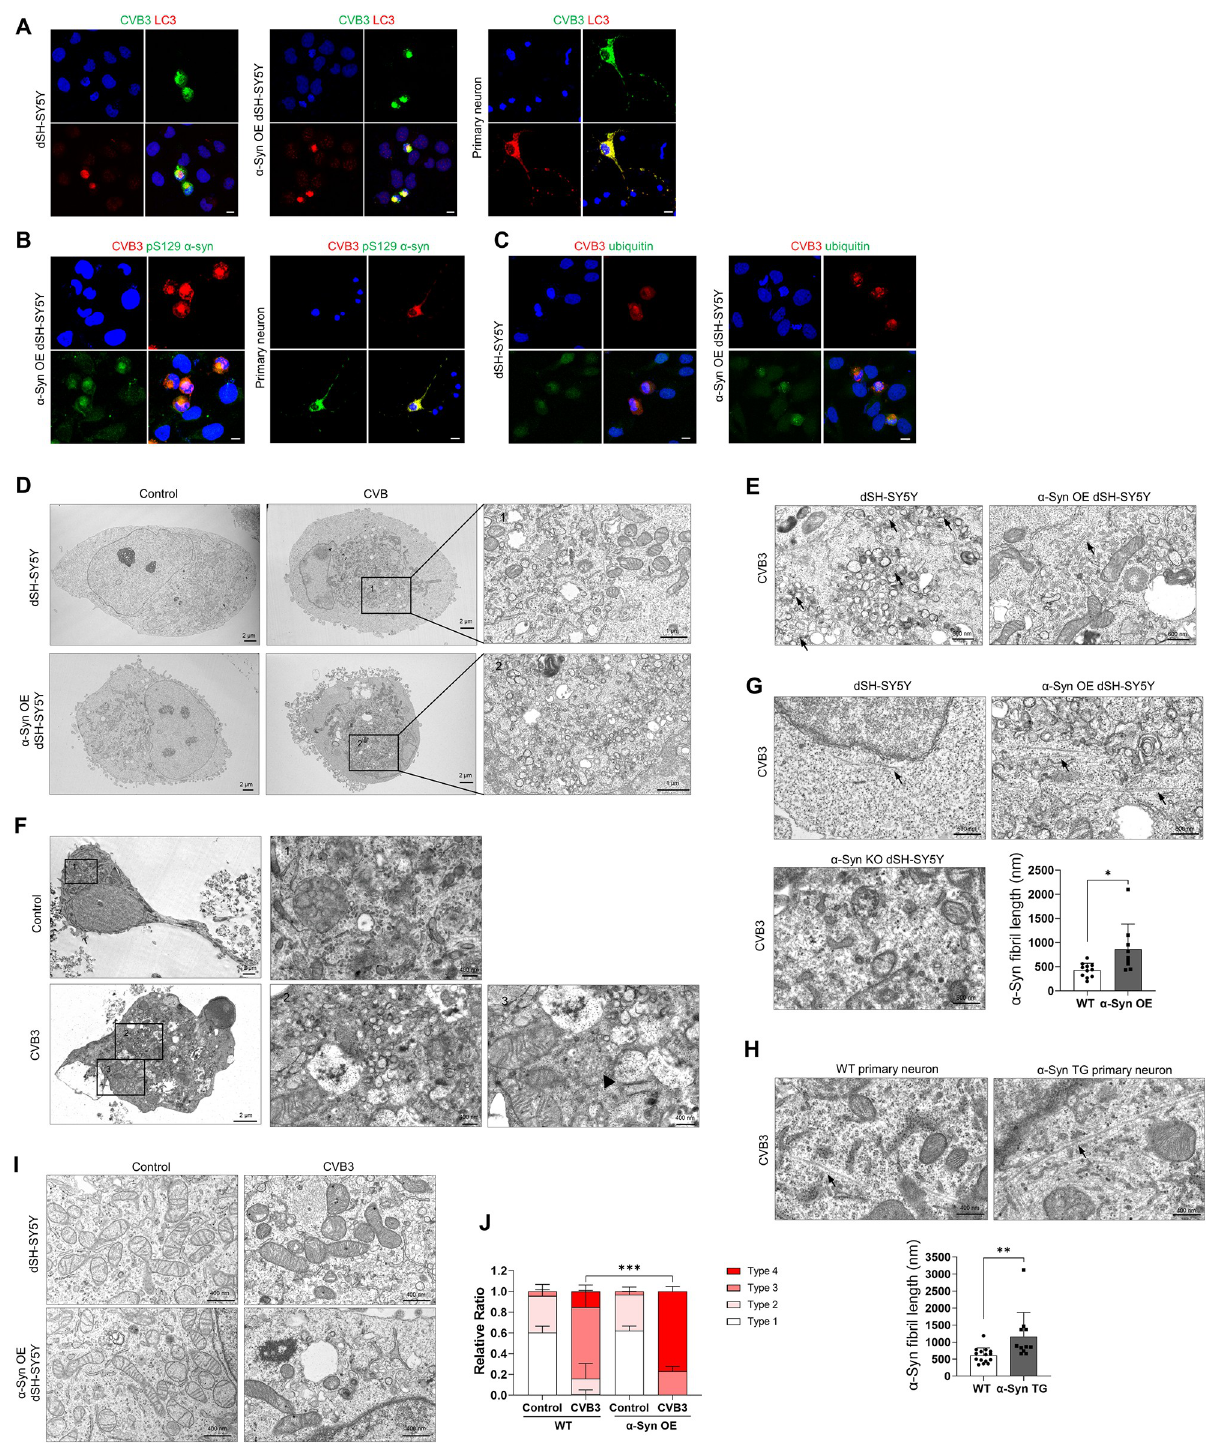
Fig 2. CVB3 infection induces Lewy body-like inclusion body formation in neurons. (A) ICC images of WT, α -syn OE dSH-SY5Y cells and mouse primary cortical neurons infected by CVB3 (MOI 0.25 or 5) for 24 h. Cells were immunostained for CVB3 VP1 (green) and MAP1LC3B (LC3) (red). (B) ICC images of α -syn OE dSH-SY5Y cells and mouse primary cortical neurons infected with CVB3 for 24 h. Cells were immunostained for CVB3 VP1 (red) and pSer129 α -syn (green). (C) ICC images of WT and α -syn OE dSH-SY5Y cells infected with CVB3 for 24 h. Colocalization of CVB3 VP1 (red) and ubiquitin (green) was observed. Scale bar indicates 10 μ m. Blue indicates Hoechst. (D) Transmission electron microscopy (TEM) images of control and CVB3 infected WT and α -syn OE dSH-SY5Y cells which were infected with CVB3 for 24 h. (E) TEM images of WT and α -syn OE